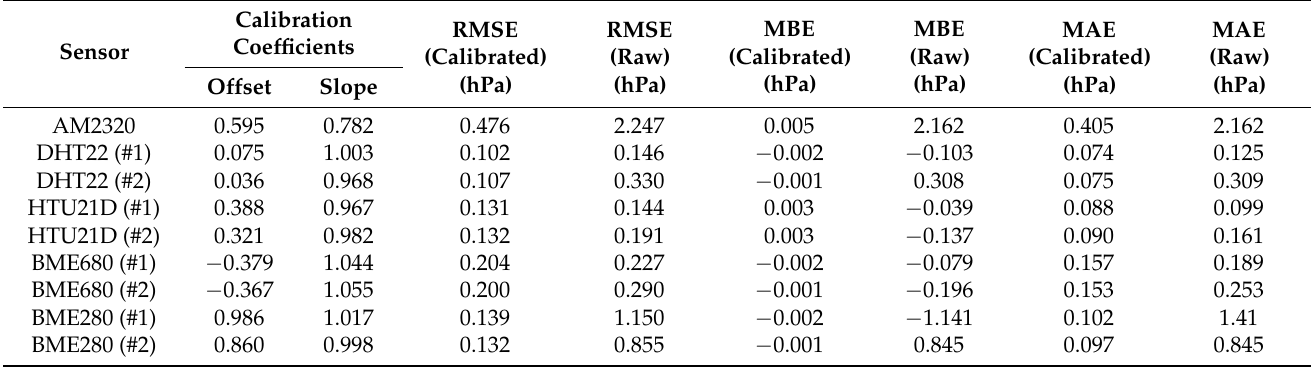
Table A2. Individual calibration coefficients (offset and slope), root mean square error (RMSE), mean bias error (MBE), and mean absolute error (MAE) for the calibrated and raw values of the vapor pressure of the tested air humidity sensors.